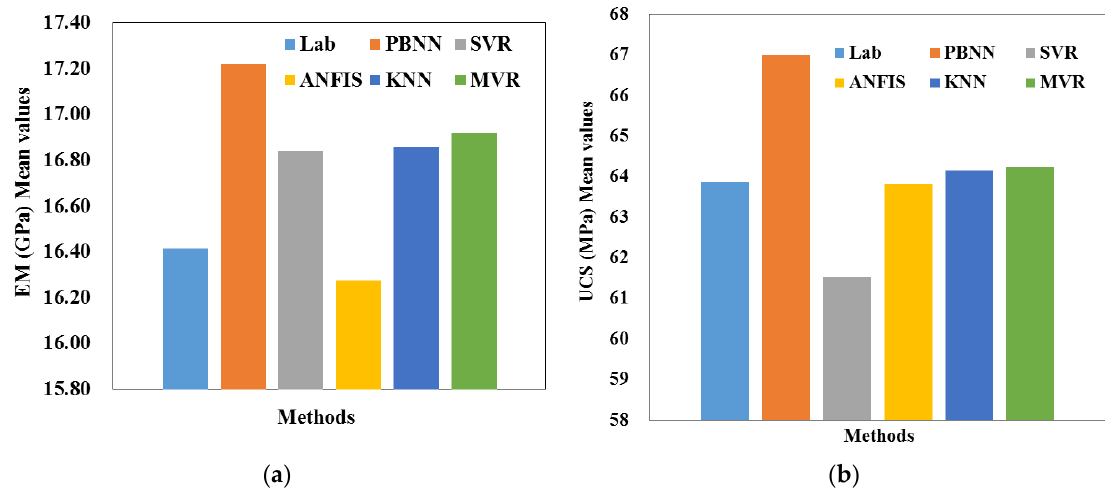
Figure 14. Comparison of used methods to estimate EM ( a ) and UCS ( b ).